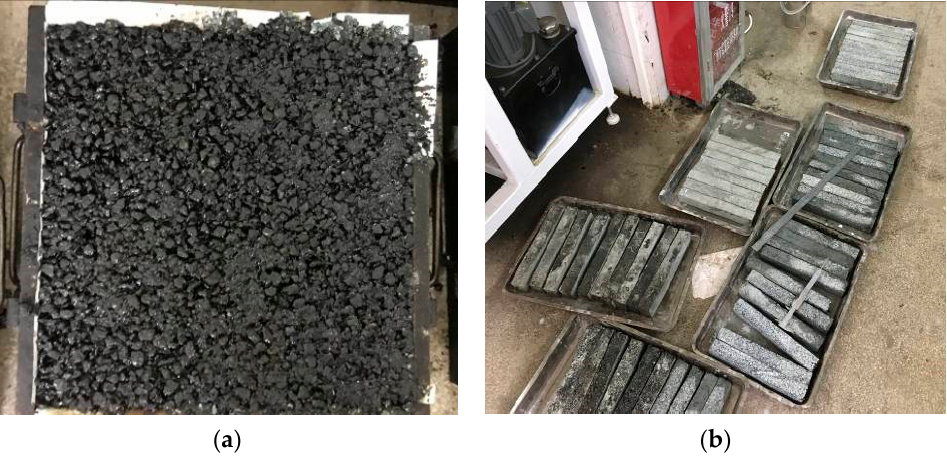
Figure 8. Specimen fabrication: ( a ) formed rut plate; ( b ) cutting beam.